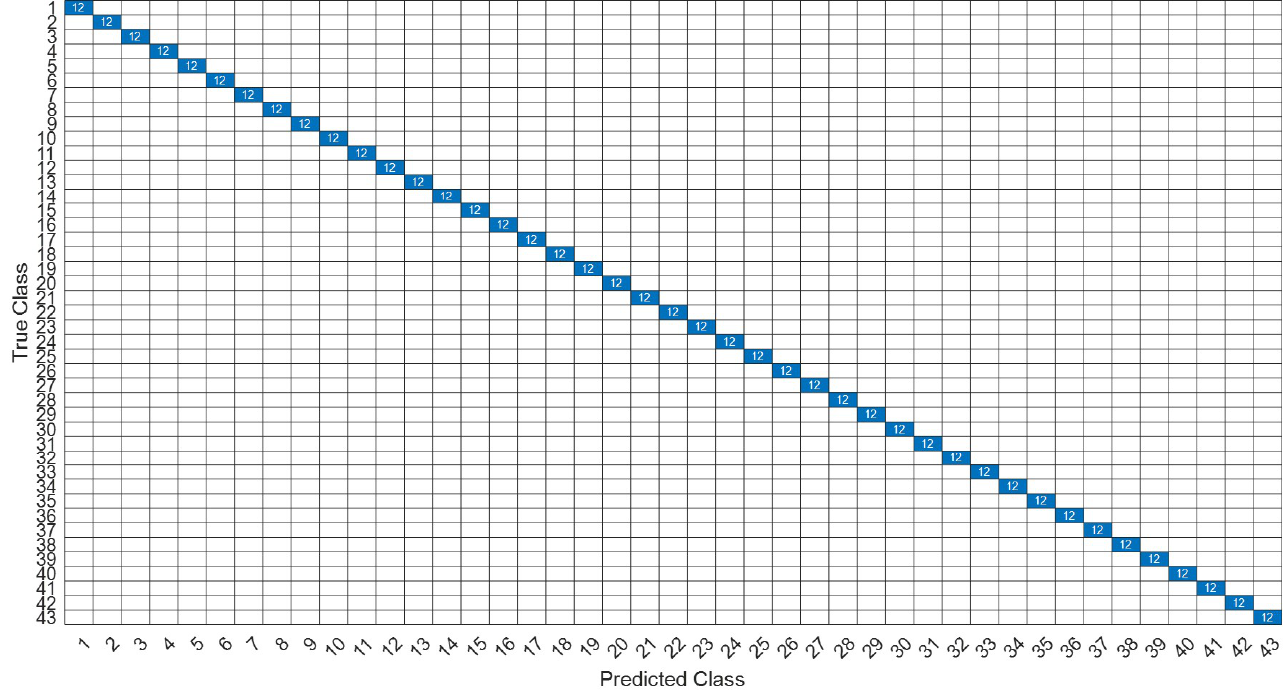
Figure 33. The confusion matrix of the LSTM model with wavelet 40-features dataset.